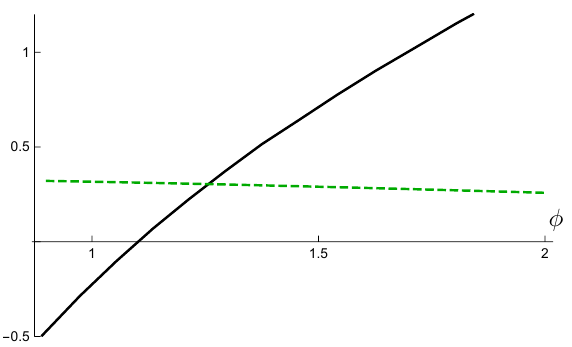
Figure 7 . Results for the highly symmetric three genus Riemann surface. The black (solid) line is I con (cid:0) I dis , the green (dashed) one 1 (cid:0) j h AB j 2 l